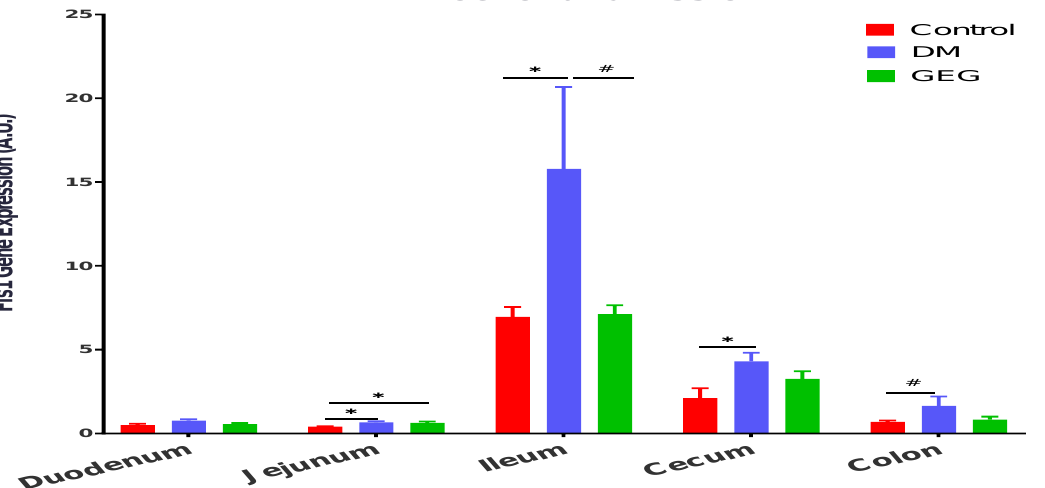
Figure 7. Effect of gingerol-enriched ginger (GEG) on mRNA gene expression of FIS1 in duodenum, jejunum, ileum, cecum, and colon of rats. Data is expressed as mean ± SEM. n = 6–8 per group. Data was analyzed by one-way ANOVA followed by a post hoc Tukey’s test. * p < 0.05. # 0.05 < p < 0.1. We evaluated the effects of GEG supplementation on PGC-1 α gene expression, a multi-functional transcriptional coactivator involved in mitochondrial biogenesis, in DM rats (Figure 8). The gene expression levels of PGC-1 α were higher in the duodenum, jejunum, ileum, and cecum of the DM groups than those in the control group (Figure 8). GEG supplementation in the diet suppressed the T2DM-induced PGC-1 α gene expression in the duodenum, jejunum, ileum, and cecum (Figure 8). We examined GEG’s effects on